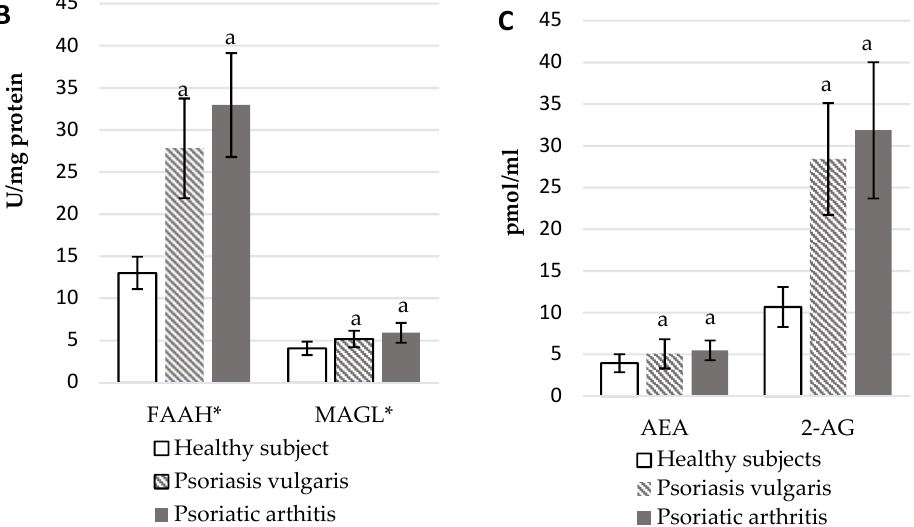
Figure 3. Endocannabinoid system receptor expression in granulocytes* of healthy subjects (n = 8) and patients with psoriasis vulgaris (n = 16) and psoriatic arthritis (n = 8) ( A ), endocannabinoid levels, ( C ) and activity of enzymes metabolizing endocannabinoids in plasma ( B ) of healthy subjects (n = 34) and patients with psoriasis vulgaris (n = 68) and psoriatic arthritis (n = 34). a p < 0.05 when compared with healthy subjects and x p < 0.05 when compared with patients with psoriasis.